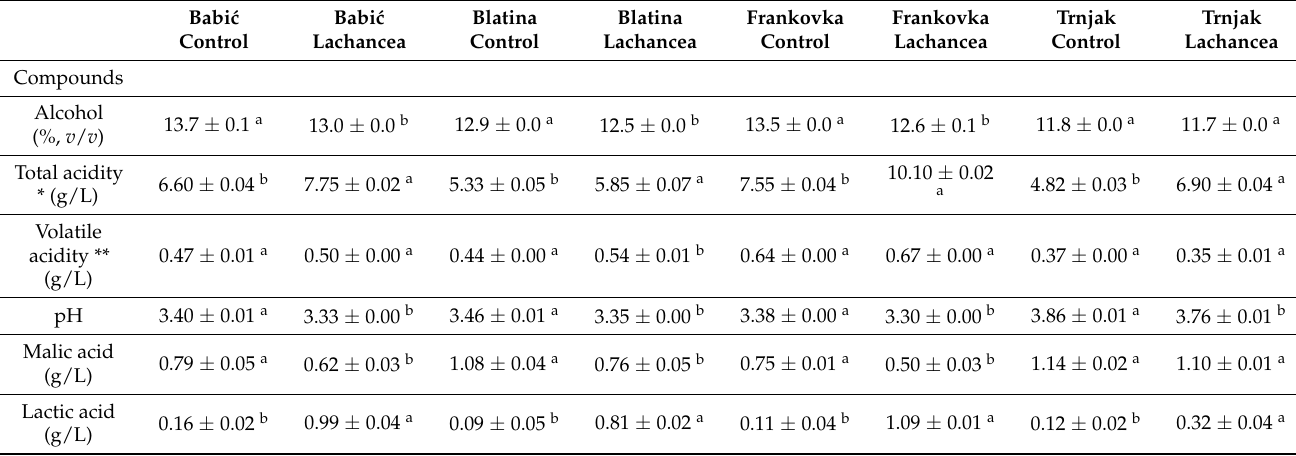
Table 1. Physicochemical properties of Babi´c, Blatina, Frankovka, and Trnjak wines. Babi´c Babi´c Blatina Control Lachancea